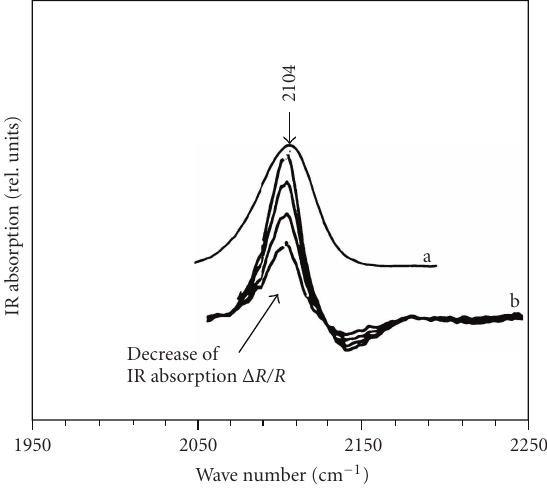
Figure 9: Shape of ex situ IR-CN stretch-line (2104 cm − 1 ) of N3 sensitizer (a) compared to lineshape characteristic for photodegra- dation loss after passage of 1.4, 5.4, 9.5, and 14mC cm − 2 of photoelectrical charge through the dye sensitized cell, (b) measured in total reflection